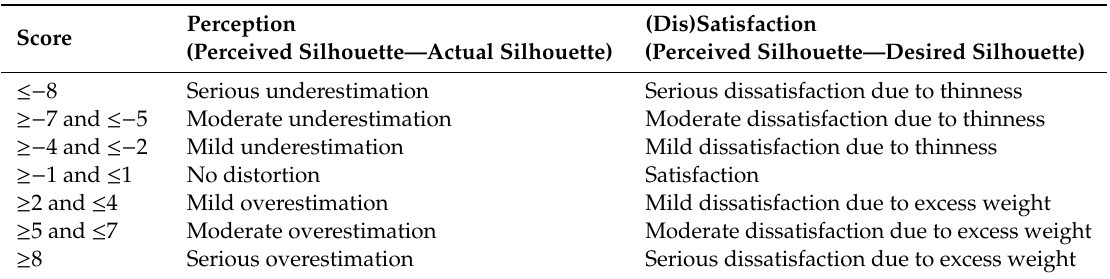
Table 1. Categories of body size perception and body image